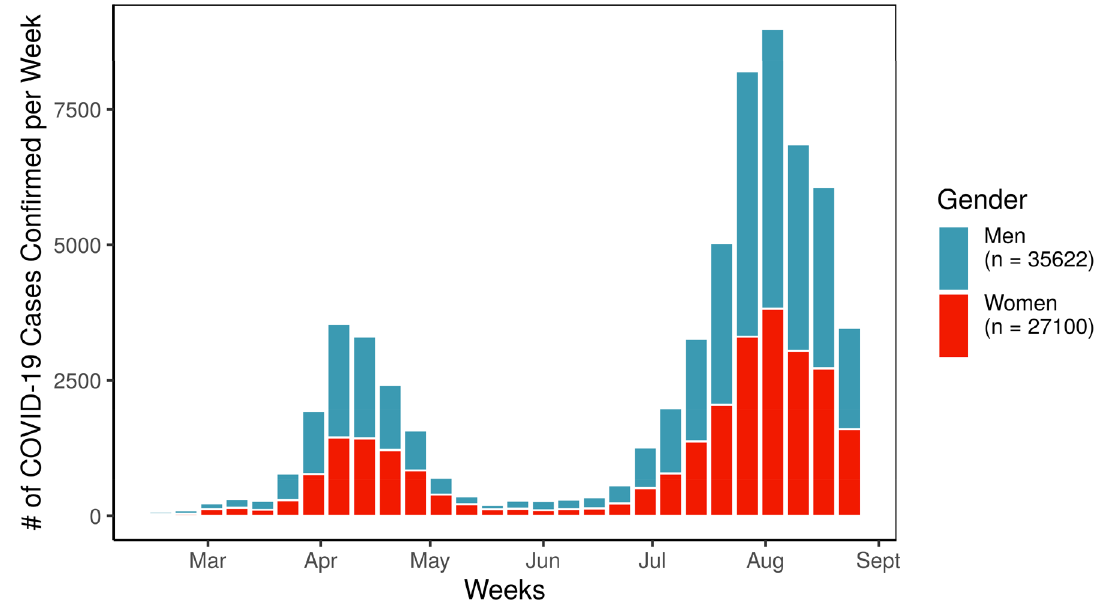
Figure 1. COVID-19 cases confirmed over time in JAG japan